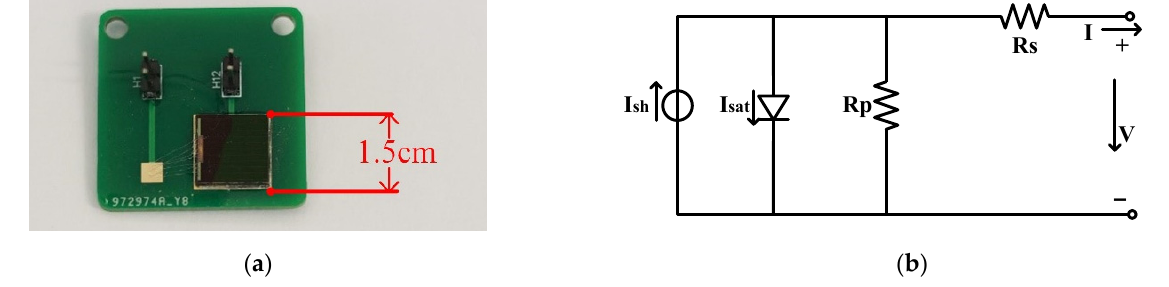
Figure 1. ( a ) Photograph of the PV cell; ( b ) Equivalent circuit diagram of a PV cell.